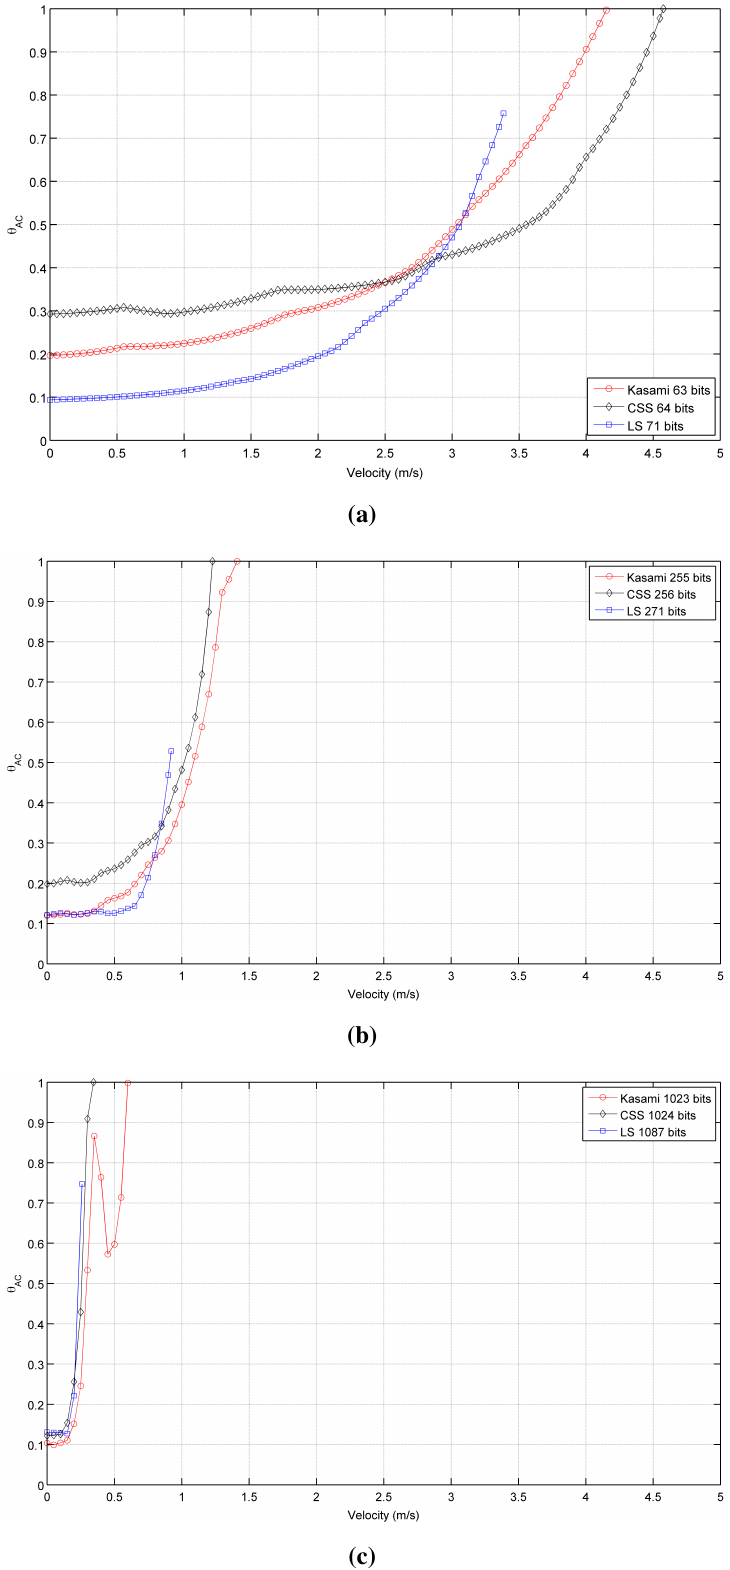
Figure 5. Simulated auto-correlation bound for the sequences with lengths close to (a) 64 bits (b) 256 bits (c) 1,024 bits (transducer response and atmospheric absorption are